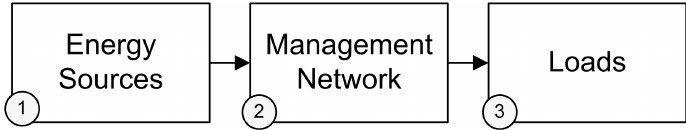
Figure 1. Elements of a HPS network. Energy storage units (batteries) are simultaneously considered as “energy sources” and